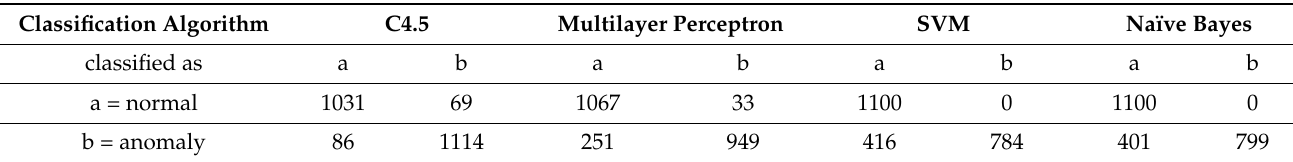
Table 6. Confusion matrix for different classification algorithms. Classification Algorithm